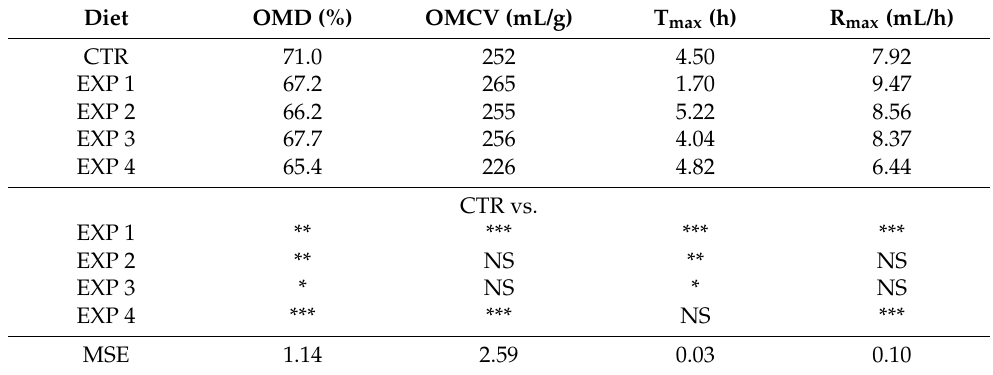
Table 3. In vitro fermentation parameters: control vs. experimental diets with bovine inoculum .